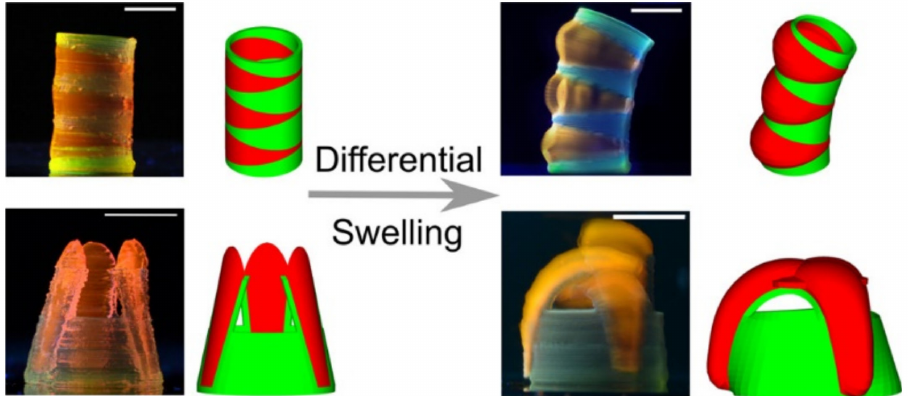
Figure 5. Shape-changing 3D constructs made of thermally responsive NIPAM/LAP swelling gel (red) and PAAM/LAP (green). Figure reproduced with permission from [29], American Chemical Society, 2019.